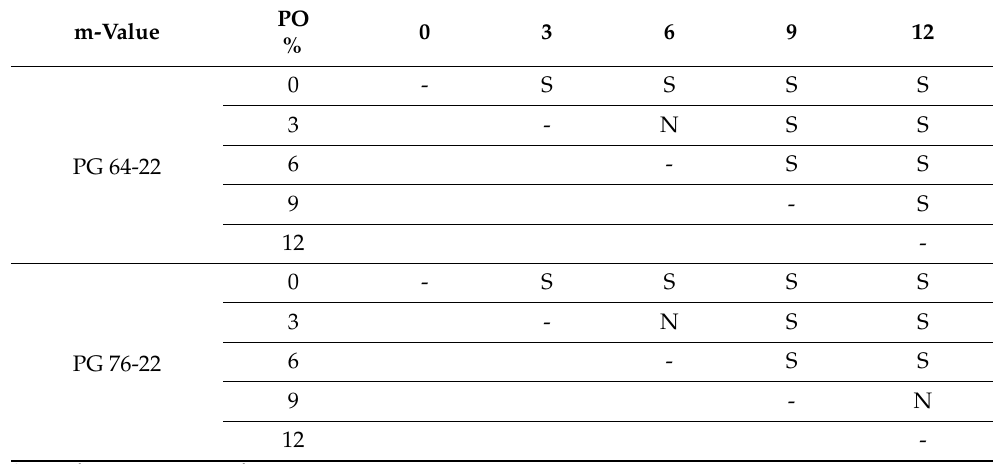
Table 10. Statistical analysis results of the m-value as a function of processed oil content − 12 ◦ C ( α = 0.05).